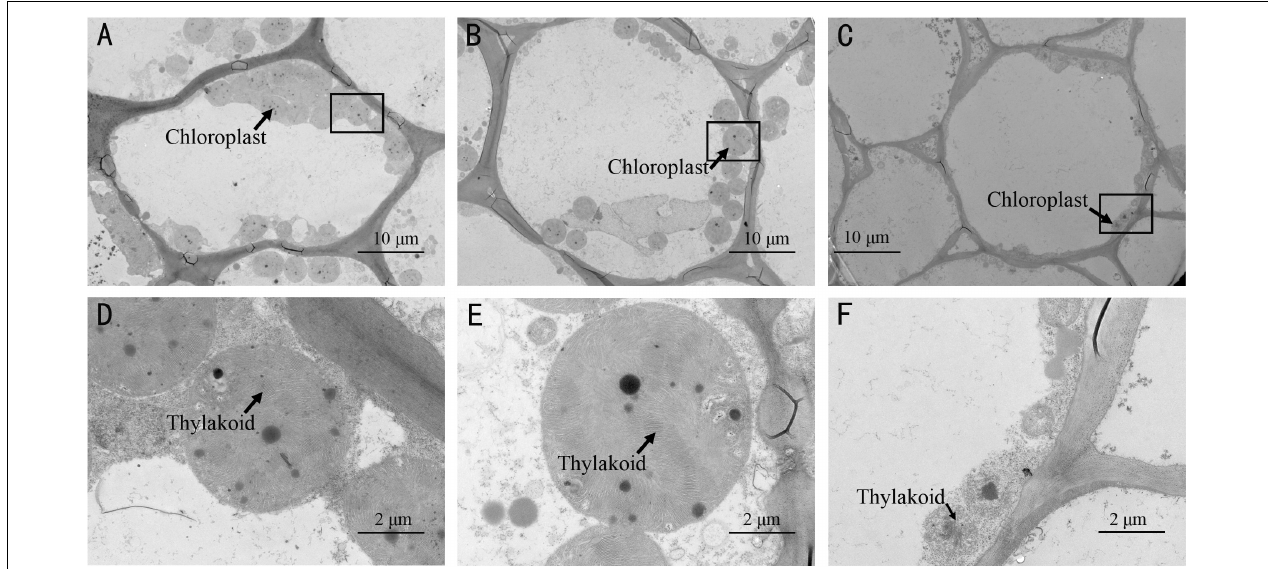
FIGURE 3 | Transmission electron microscopy (TEM) observation of chloroplasts in the spotted peels of SC (A,D) and non-spotted peels of SC (B,E) , and MG (C,F) . (D–F) Magnified views of the boxed regions in (A–C) , respectively.